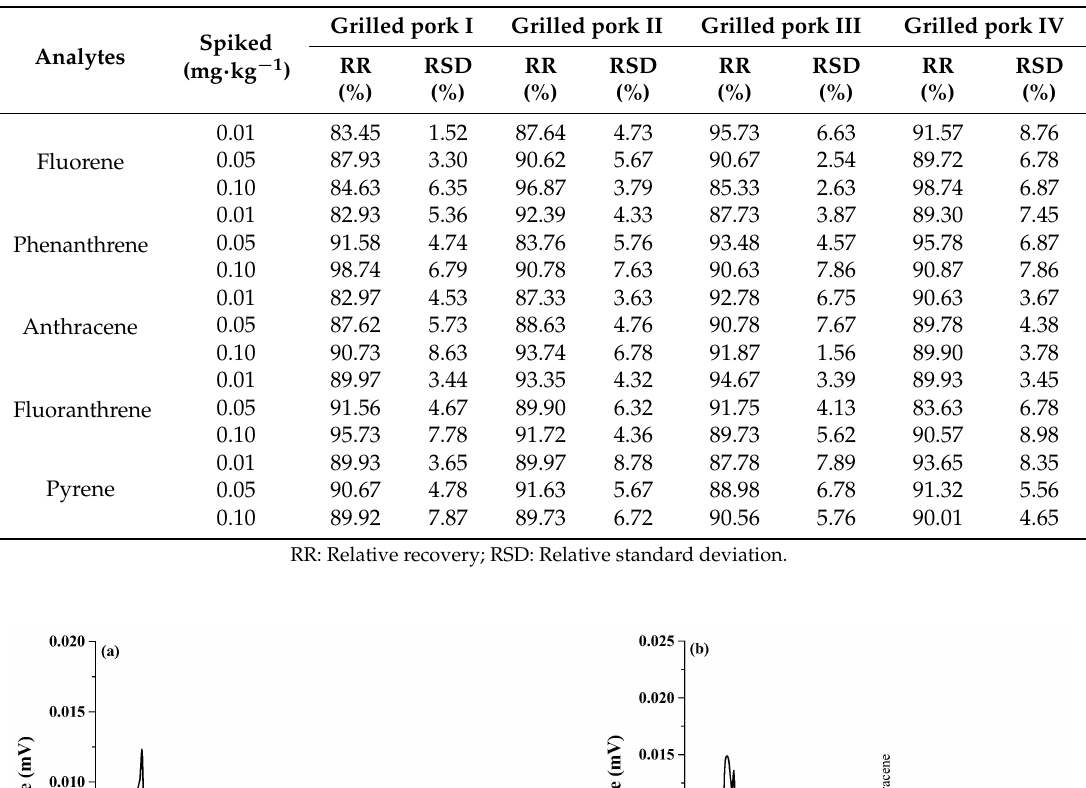
Table 3. Recovery obtained from the determination of polycyclic aromatic hydrocarbons in the studied grilled pork samples ( n = 3).